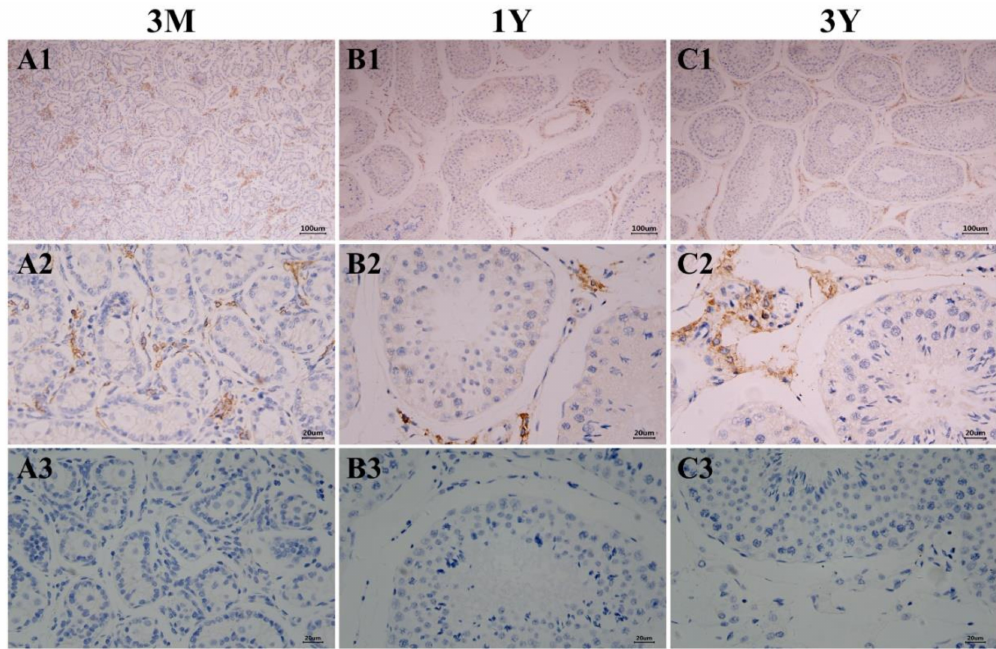
Figure 6. Immunohistochemical staining of the GLOD4 protein in developmental Tibetan sheep testes. ( A1 – C1 ) Immunostaining patterns of GLOD4 protein (brown) in 3M, 1Y and 3Y sheep testes (100 × ); ( A2 – C2 ) Immunostaining patterns of GLOD4 protein (brown) in 3M, 1Y and 3Y sheep testes (400 × ); ( A3 – C3 ) The primary antibody was replaced with phosphate-bu ff ered saline (PBS) as the negative controls (400 × ). The experiment was biologically repeated eight times, and technically repeated two times for each biological replicate. 3M: 3 months old; 1Y: 1 year old; 3Y: 3 years